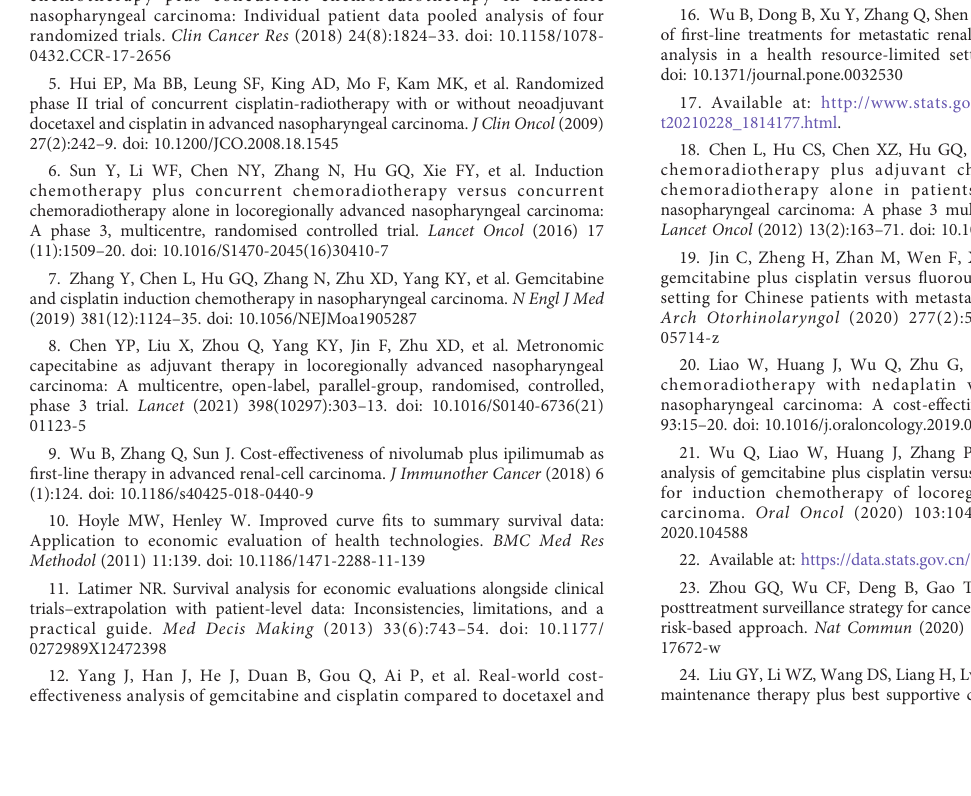
SUPPLEMENTARY FIGURE 1 Markov model states. The progress states of locoregionally advanced nasopharyngeal carcinoma